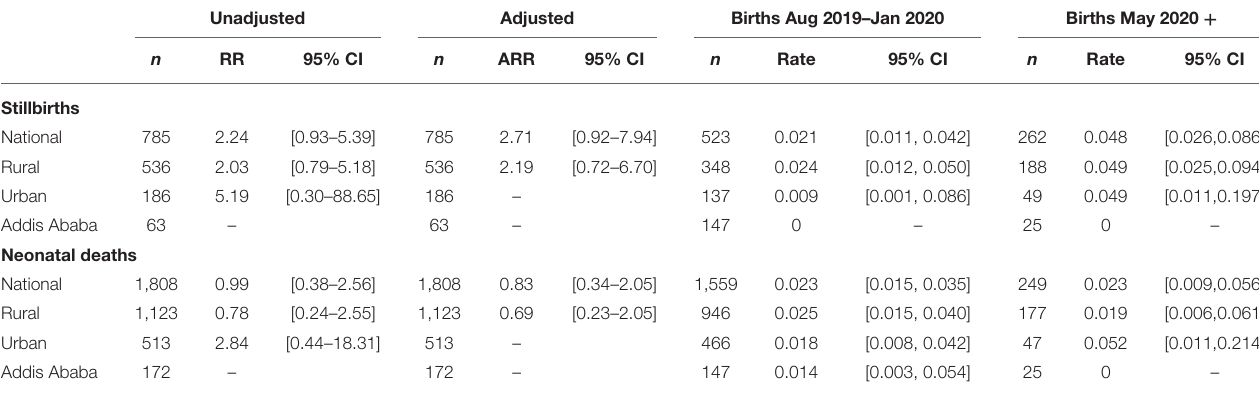
TABLE 4 | Differences in stillbirth and neonatal death rates in COVID-19 impacted cohort vs. unaffected reference cohort by strata. Unadjusted